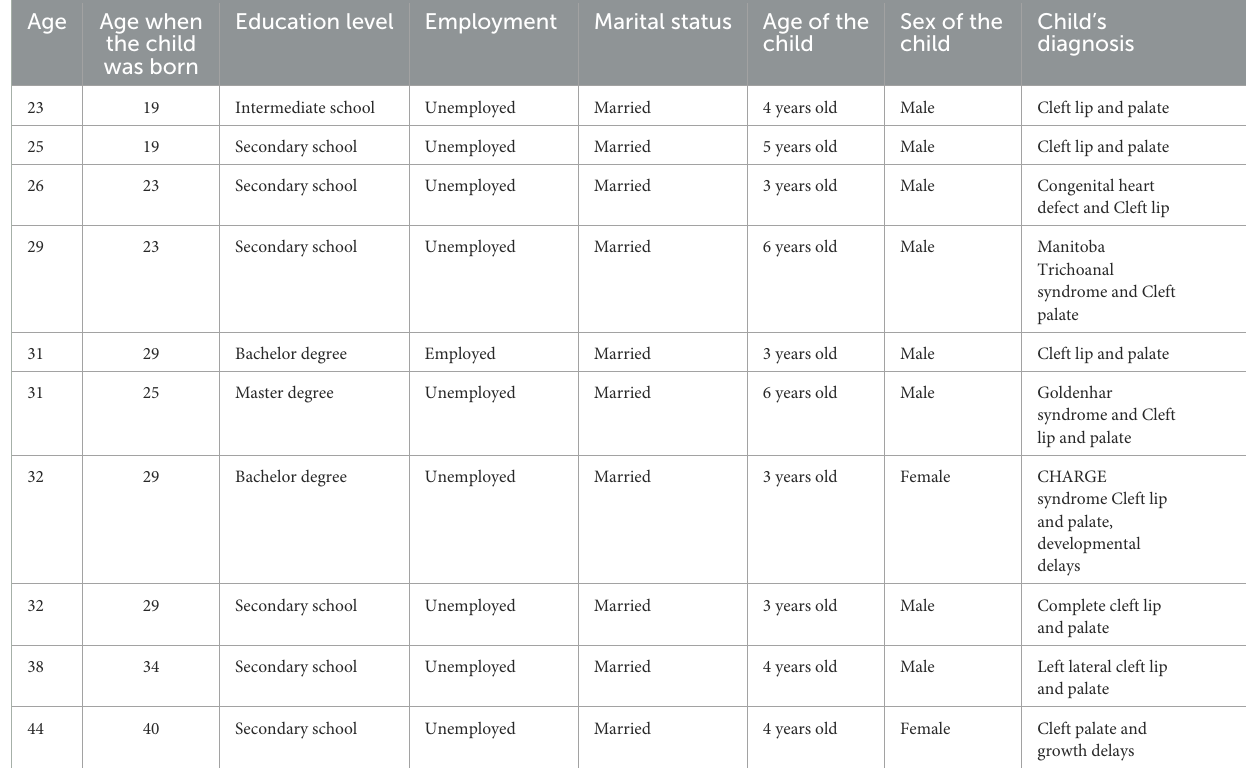
TABLE 1 Demographic data of the